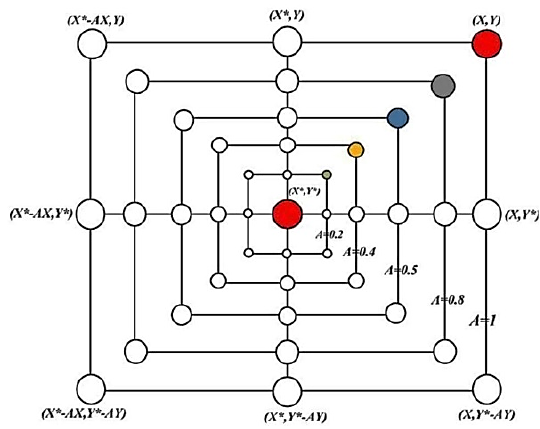
Figure 4. Bubble-net searching mechanism [37].